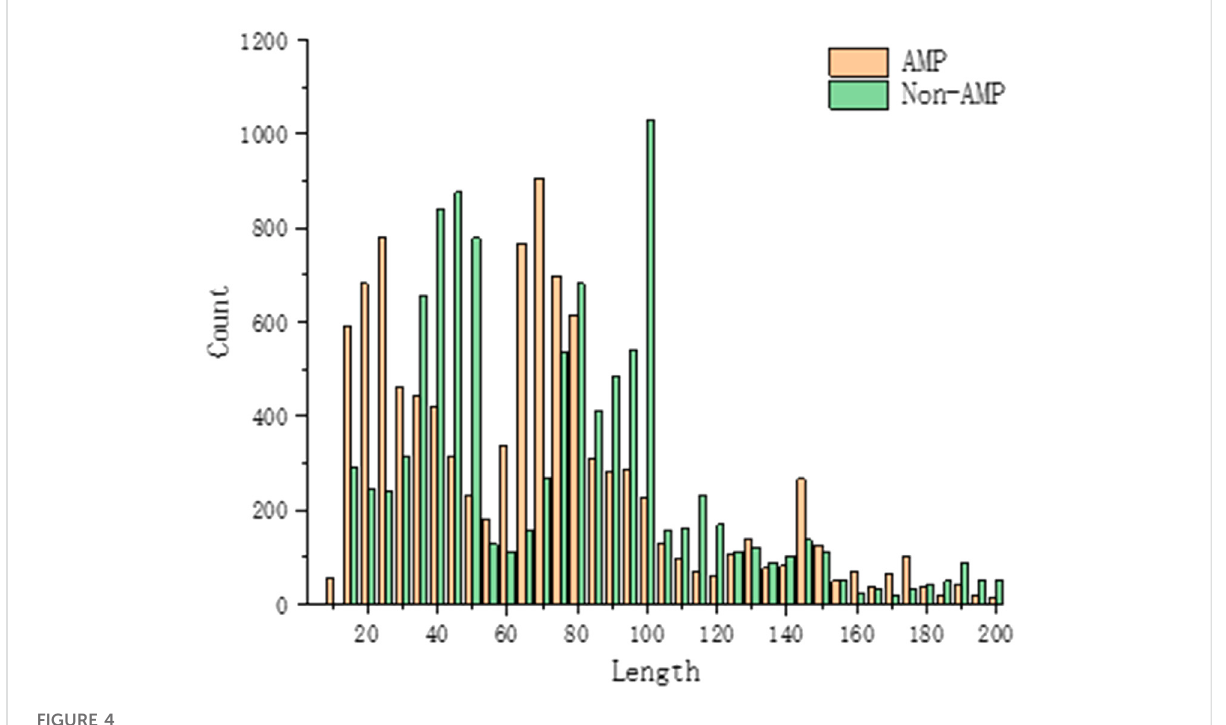
FIGURE 4 Benchmark dataset protein sequence length